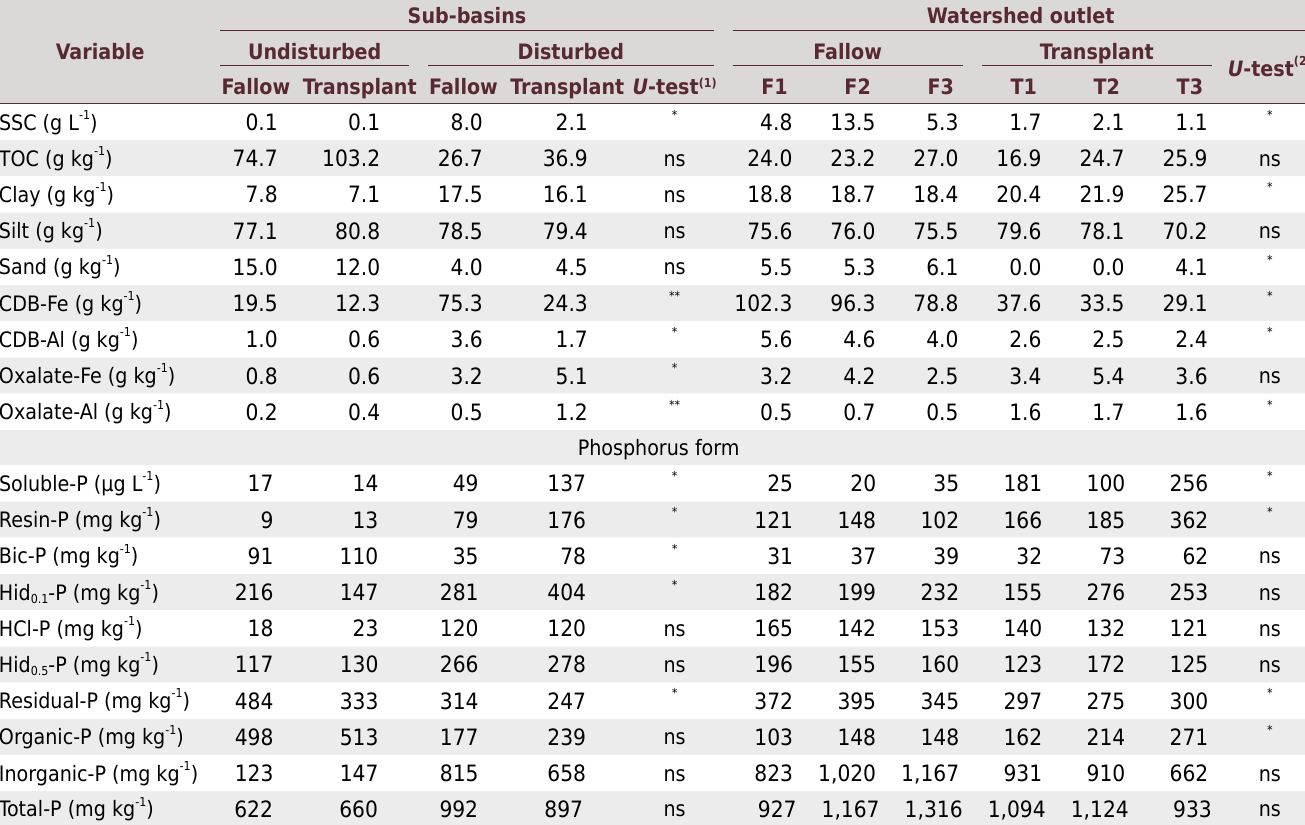
Table 2. Physicochemical properties and phosphorus forms in sediments eroded from undisturbed areas (B1) and disturbed areas (A1, A2, B2, C1, and C2) and during the phases of ascension (1), maximum flow rate (2), and recession (3) at the watershed outlet during the rainfall events that occurred during the fallow and transplanting period in the Agudo catchment, Rio Grande do Sul,